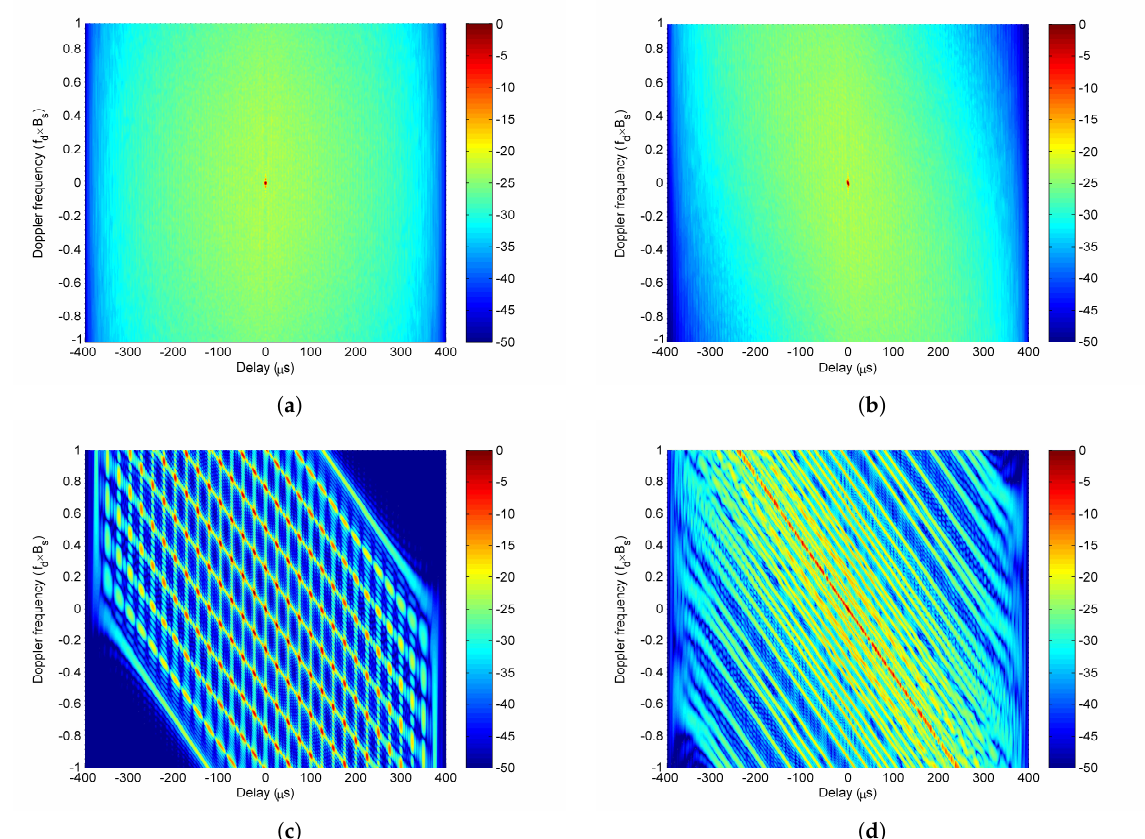
Figure 5. The ambiguity functions of ( a ) orthogonal frequency division (OFD) PC waveform set; ( b ) OFD LFM-PC waveform set; ( c ) OFD LFM waveform set; ( d ) optimized LFM waveform